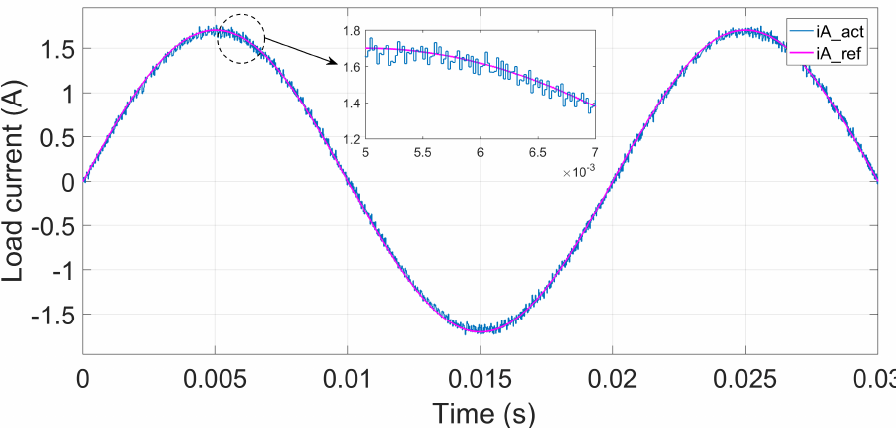
is provided, and the load current immediately tracks the reference value.